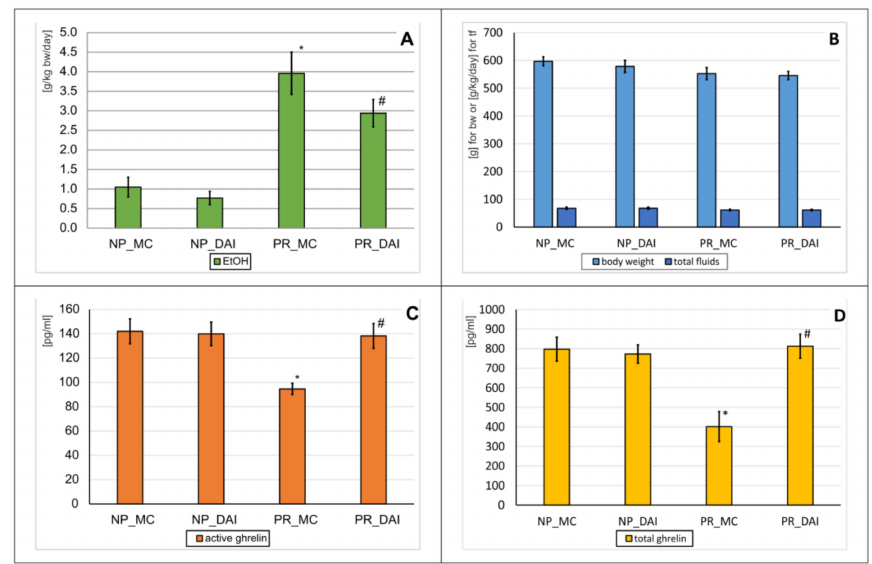
Figure 4. The effect of repeated (28 × ) daidzin (DAI) (40 mg/kg, p.o.) administration on alcohol drinking behavior, total fluid intake, body weight, and ghrelin levels in preferring (PR) and non- preferring (NP) rats. Legend: n = 8–9; mean ± SEM; PR_MC—control PR rats; NP_MC—control NP rats; MC—vehicle (0.5% methylcellulose); ( A ) amount of drunk ethanol [g/kg/day]; *—vs. NP_MC group, p < 0.001; #—vs. PR_MC group, p < 0.001; ( B ) body weight [g] and the total amount of fluid intake [g/kg/day]; ( C ) serum active ghrelin levels [pg/mL]; *—vs. NP_MC group, p < 0.001; #—vs. PR_MC, p < 0.001; ( D ) serum total ghrelin levels [pg/mL]; *—vs. NP_MC group, p < 0.001; #—vs. PR_MC, p < 0.001.